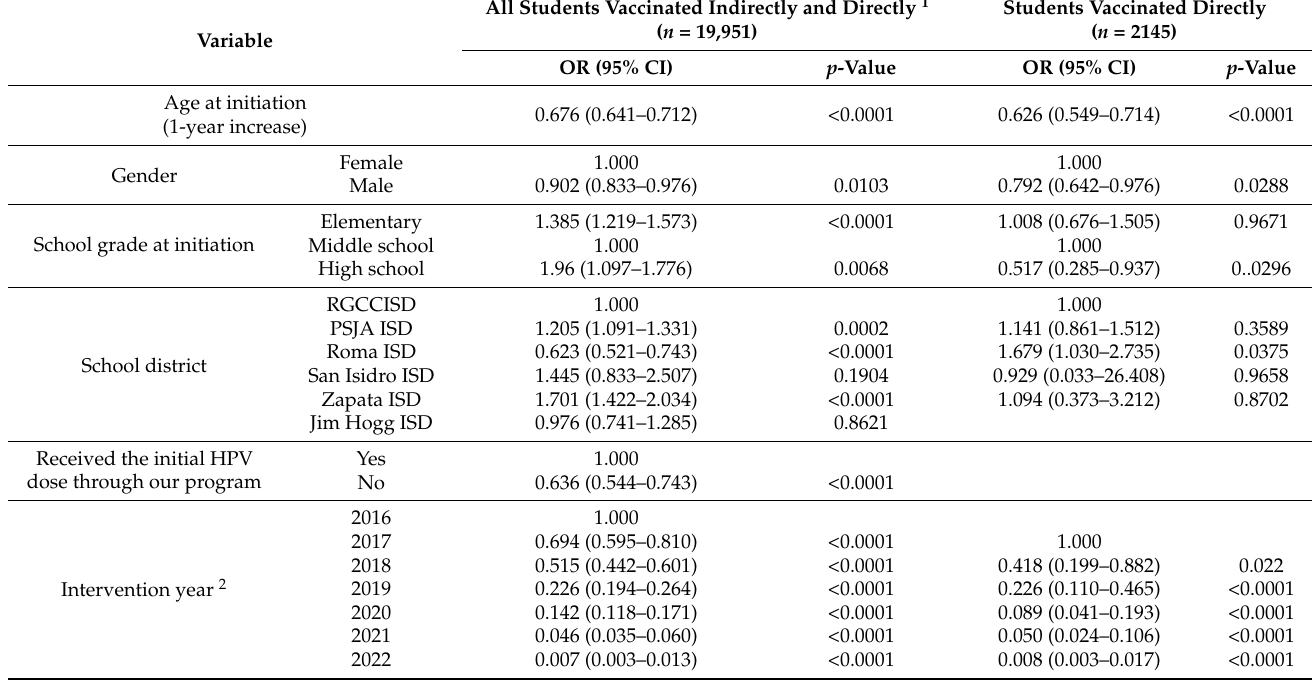
Table 3. Multivariate analysis of factors associated with HPV-UTD among all students vaccinated (indirectly and directly: n = 19,951) and students vaccinated directly through our school-based program ( n =